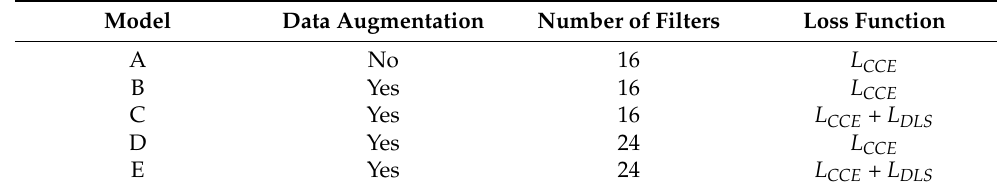
Table 1. Main differences between the trained models for the automatic segmentation task.